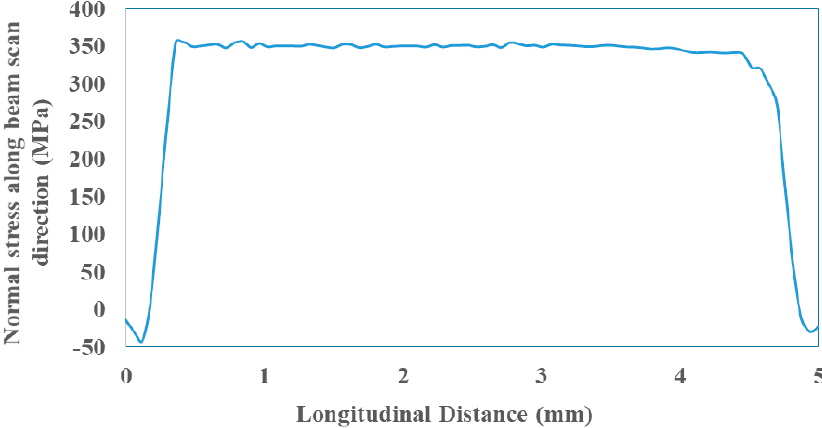
Figure 18. Current model simulation results of residual stress along with beam scan direction (length of the layers).